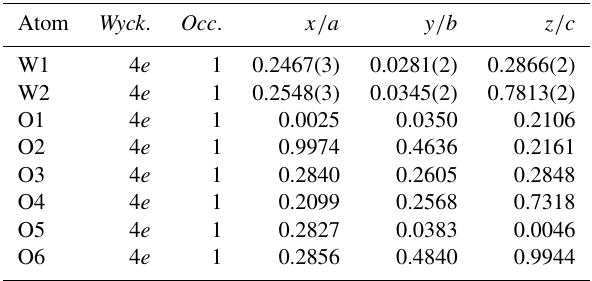
Table 3. The atom coordinates of liguowuite. “Wyck” signifies Wyckoff, and “Occ” signifies occupancy. Atom Wyck . Occ .